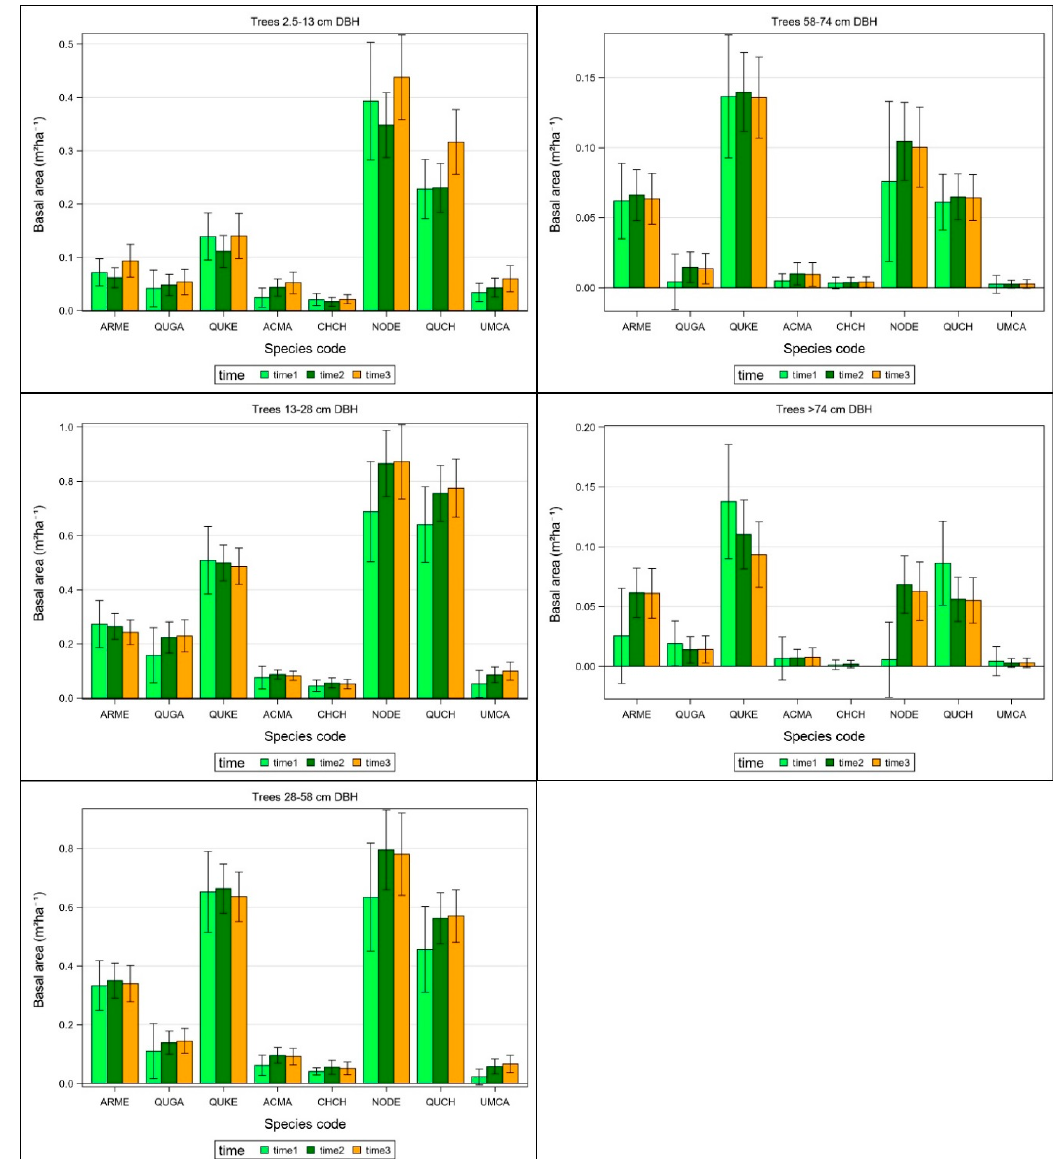
Figure 7. Species basal area by diameter class for three times with 95% confidence intervals (NFS and private lands